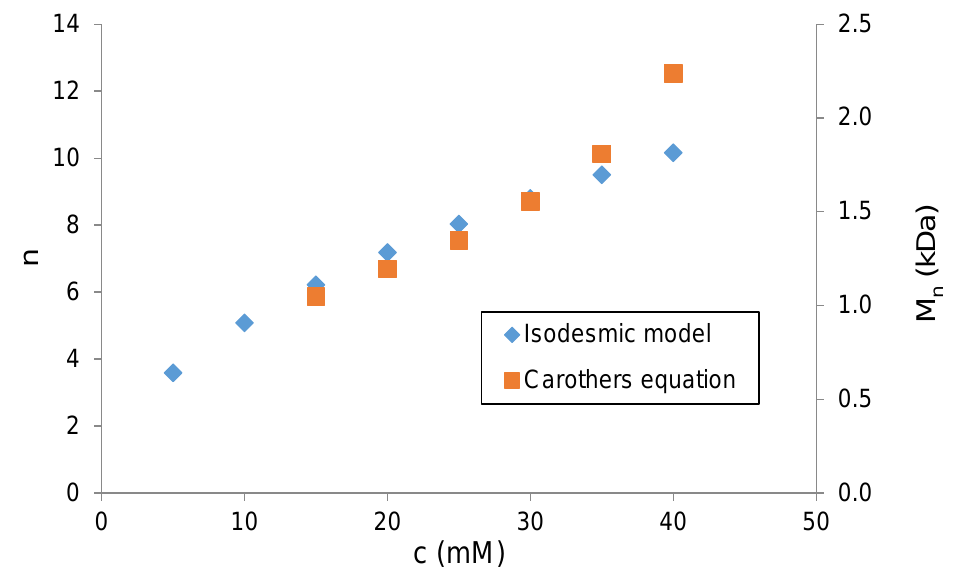
Figure 4. Degree of polymerization n and the corresponding number of average molar mass M n of supramolecular oligomer versus the concentration of 4 in D 2 O.